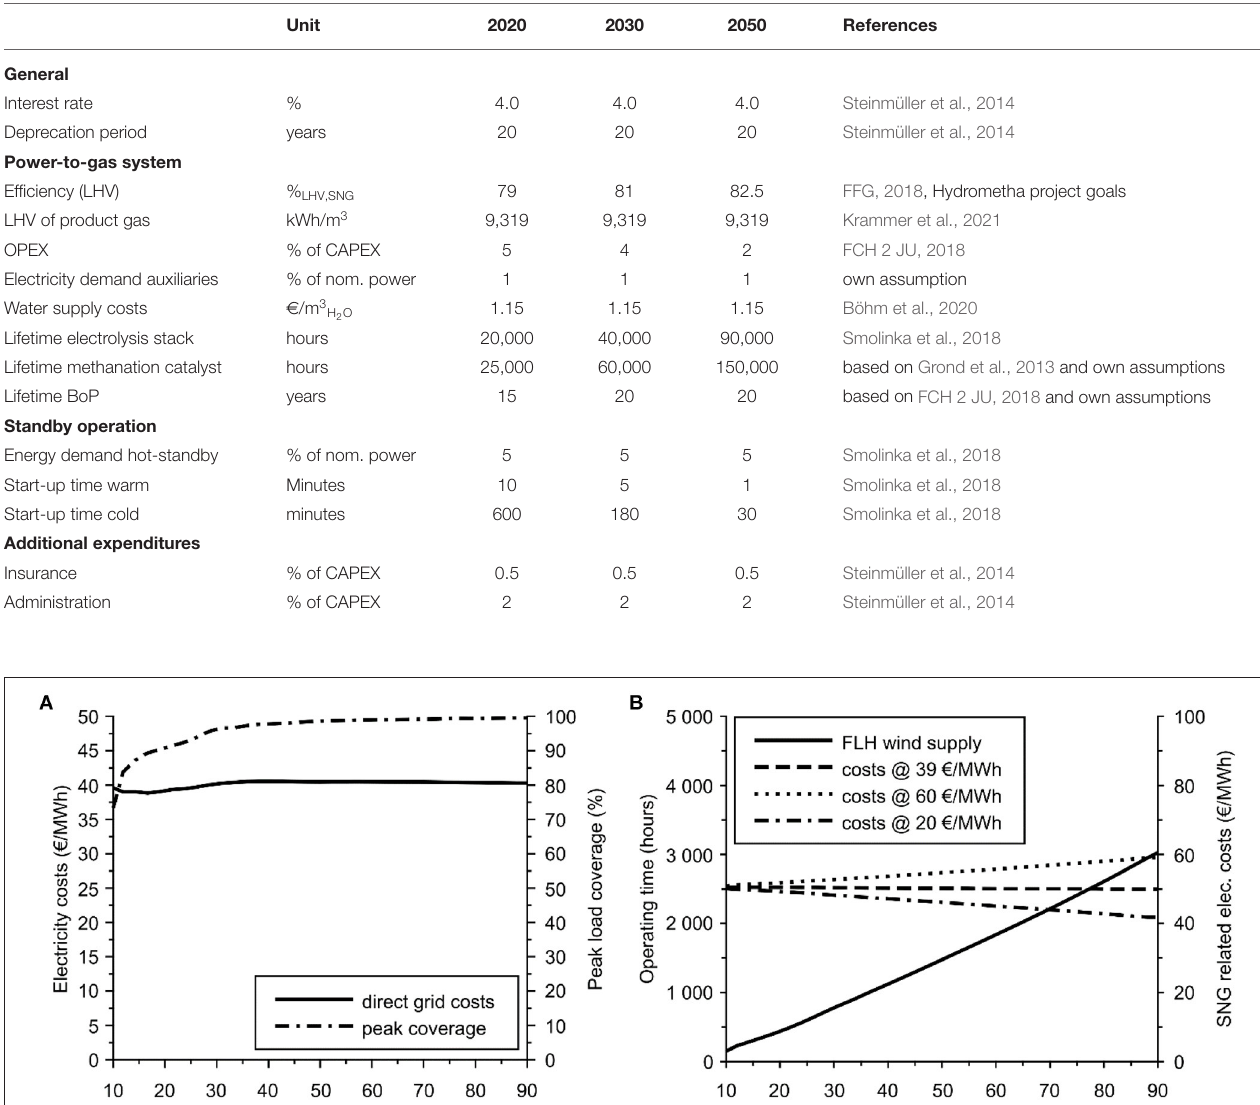
TABLE 3 | Calculation parameters for the techno-economic assessment.